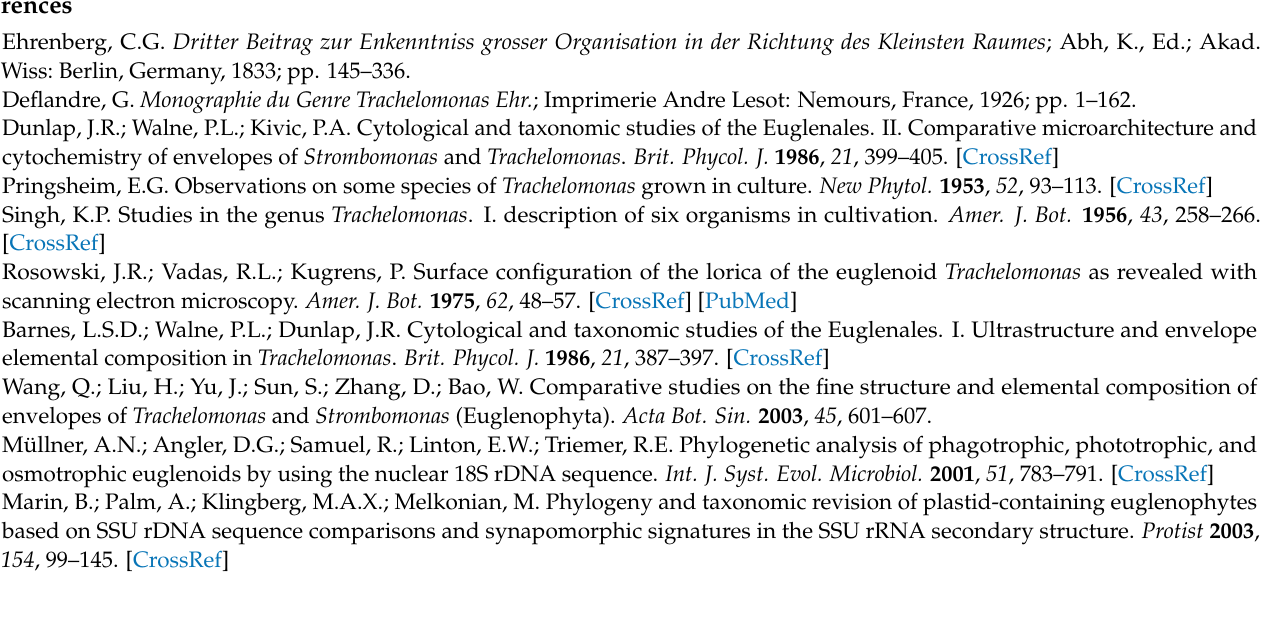
Table S2: Relevant sequence information downloaded from GenBank in this study. Figure S1: Box plot display of loricae length, loricae width, collar length, collar width, loricae length/loricae width and collar length/collar width of field samples and cultured